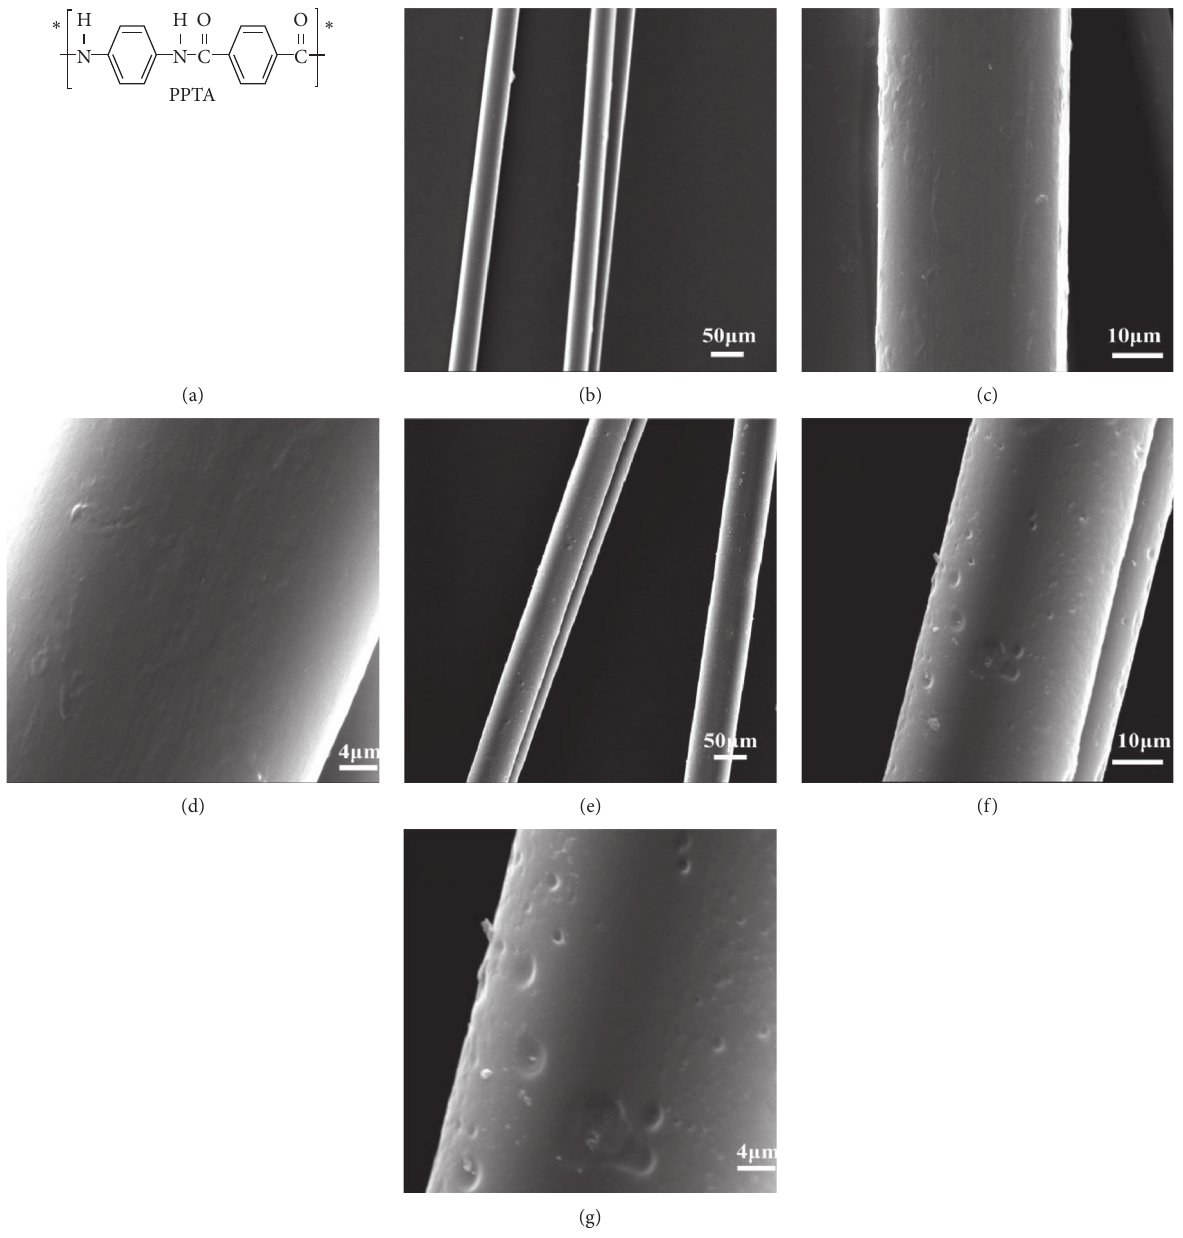
Figure 3: The chemical structure of PPTA (a); SEM micrographs of aramid fiber before (b, c, and d) and after being carbonized (e, f, and